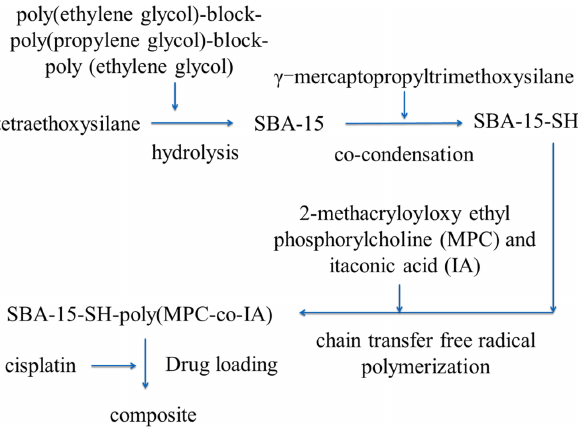
Figure 4: The synthetic route of CHAM and drug